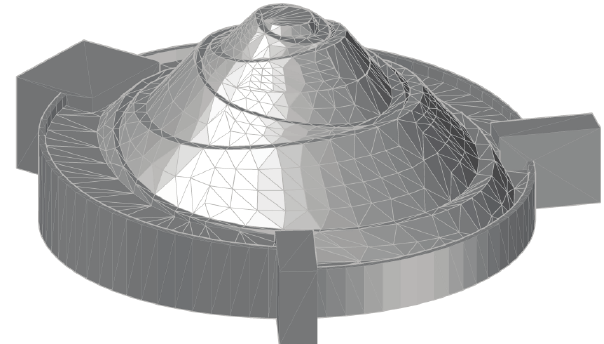
Fig. 3. Mound simplified model after